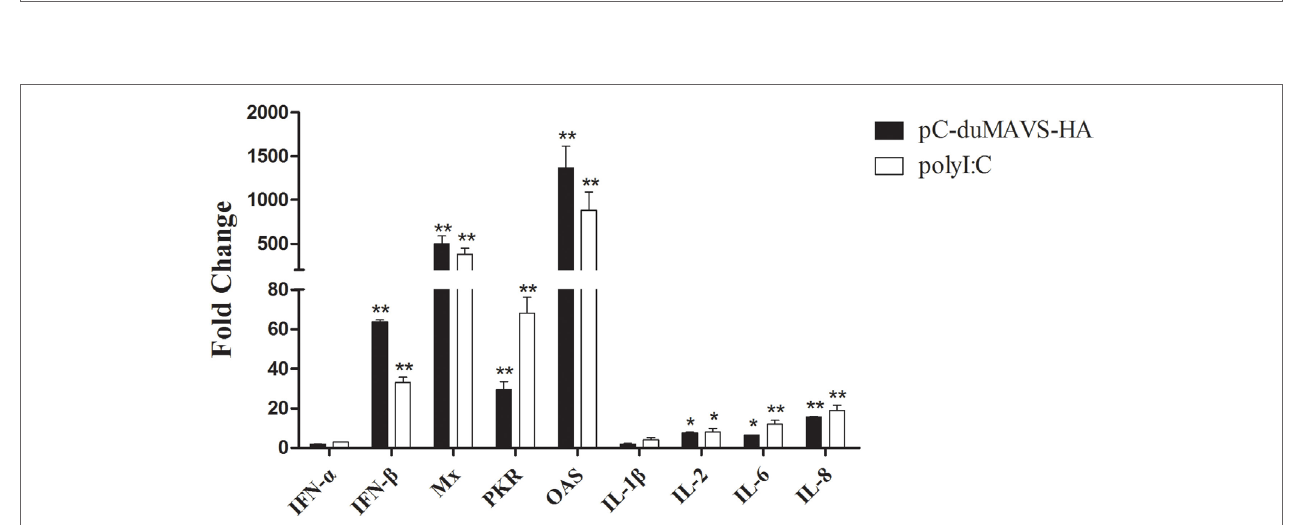
FigUre 5 | The expression of downstream factors induced by duMaVs overexpression in DeFs . The empty vector and pC-duMAVS-HA were transfected into DEFs. Cells transfected with polyI:C (2 μ g/well) were used as the positive control. The cells were collected at 24 hpt, analyzing the inducible genes expression by RT-qPCR. The relative expression levels were normalized to the β -actin gene and calculated by the 2 −ΔΔ Ct method. The fold change was calculated by the experimental groups versus control groups at the same time point. Data were means from three independent experiments and each experiment was analyzed in triplicate. Student’s t test was performed to evaluate the differences. *Significant difference ( P < 0.05); **highly significant difference ( P <